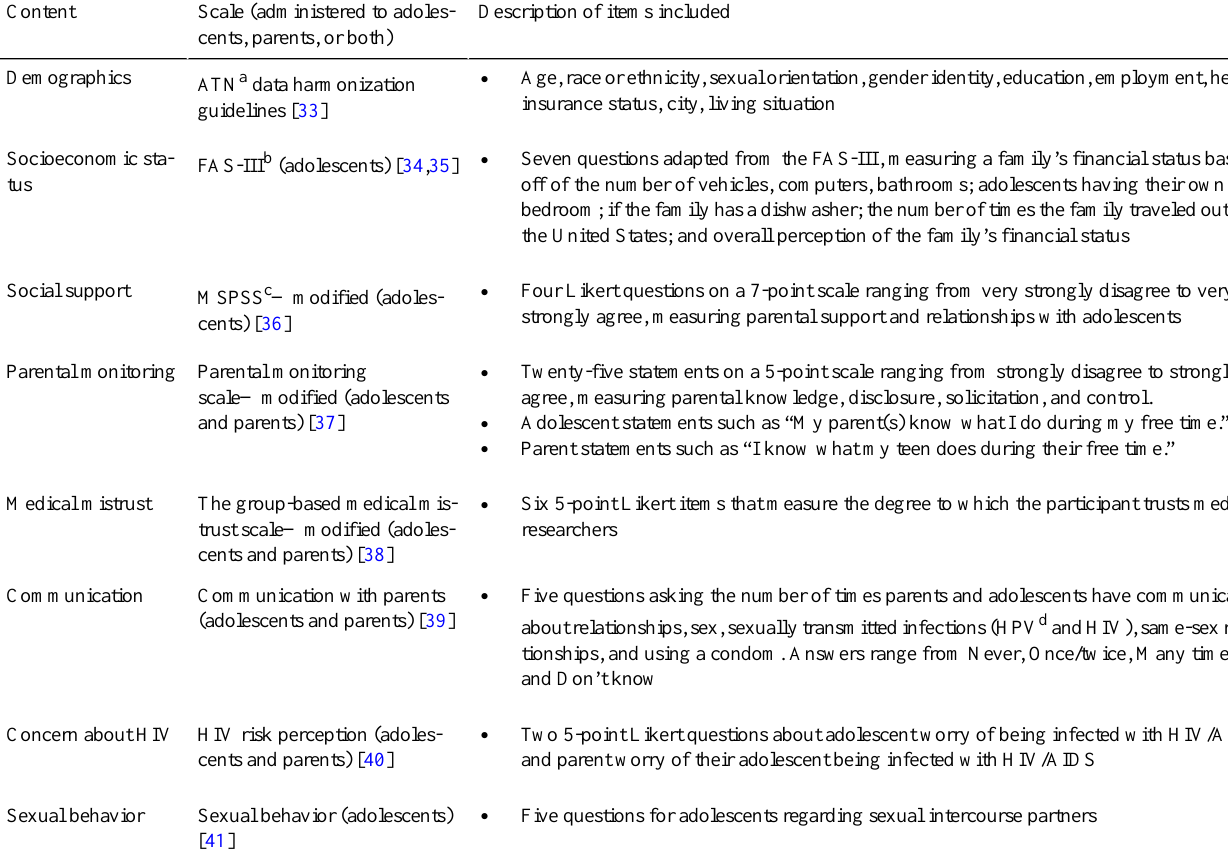
Table 1. Consent 2.0 quantitative measures.